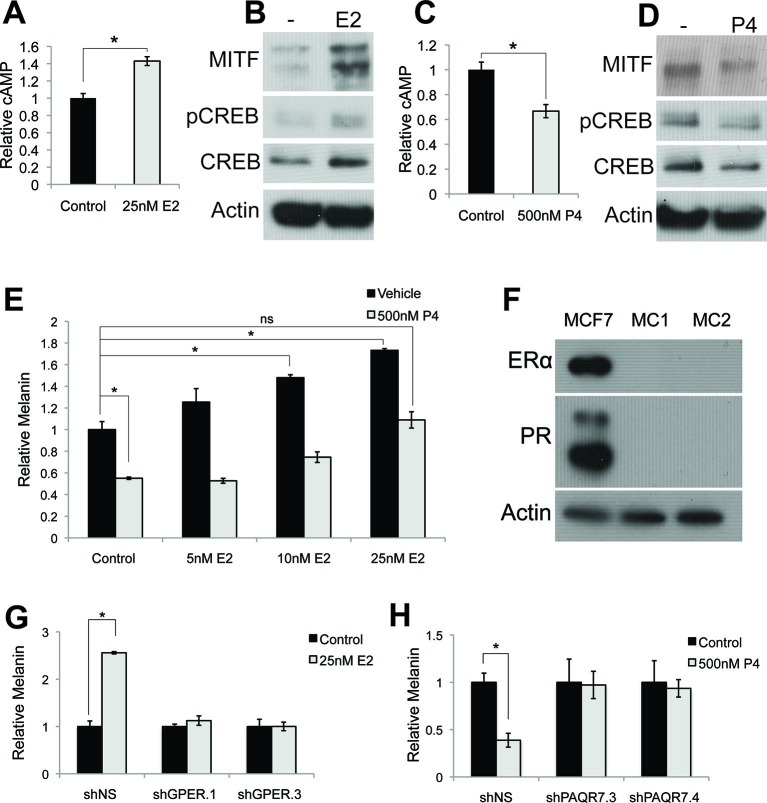
Estrogen and progesterone access the classical melanin production pathway through nonclassical receptors.(A) cAMP ELISA from estrogen-treated melanocytes (B) Western blot demonstrating changes in classical melanin pathway regulators after a 16 hr estrogen treatment. (C) cAMP ELISA from progesterone-treated melanocytes. (D) Western blot demonstrating changes in classical melanin pathway regulators after a 16 hr progesterone treatment. (E) Melanin assay from melanocytes treated with estrogen and progesterone simultaneously. (F) Western blot for estrogen and progesterone receptors in MCF7 cells and melanocytes. (G) Melanin content of melanocytes transduced with control shRNA or shRNA targeting GPER. Cells were treated with either vehicle or estrogen. (H) Melanin assay performed on melanocytes transduced with control shRNA or shRNA targeting PAQR7. Cells were treated with either vehicle or progesterone. n=3 biologic replicates for each experiment. Error bars denote +/- s.d., *p<0.05.DOI:
http://dx.doi.org/10.7554/eLife.15104.00610.7554/eLife.15104.007Figure 2—source data 1.List of GPCR transcripts expressed in primary human melanocytes.